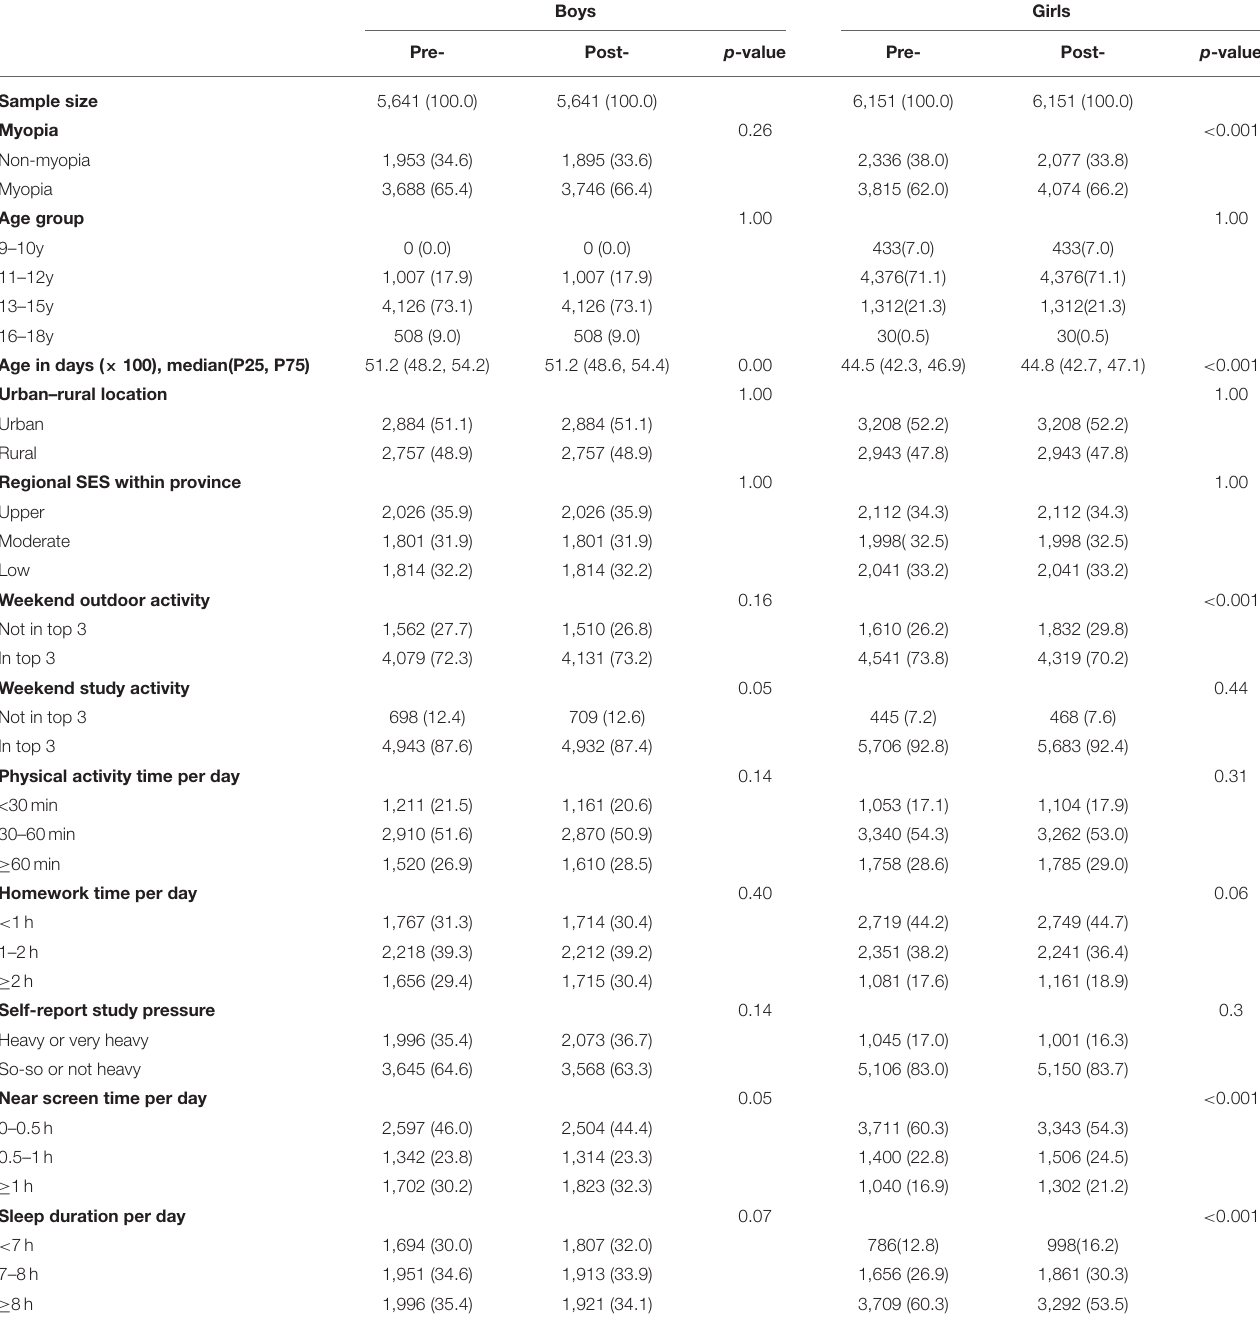
TABLE 2 | The basic characteristics of included pre- and post- menarche/spermarche subjects matched by sex, age, and school from the 2014 CNSSCH, n (%).